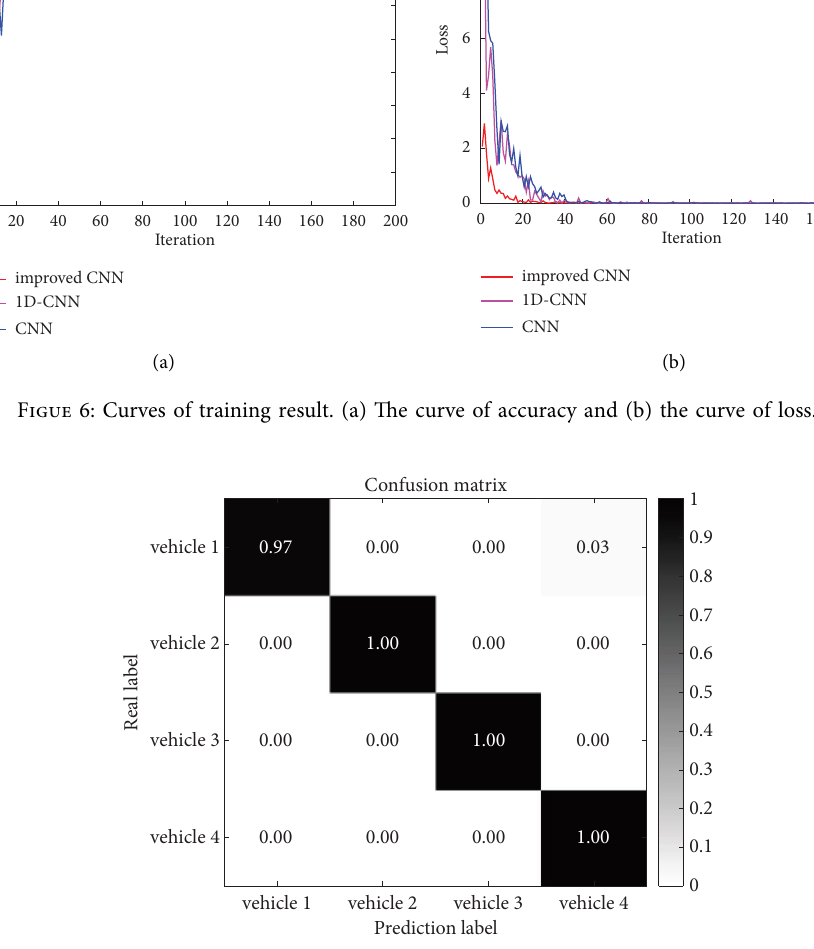
Figure 7: Confusion matrix of classifcation results.